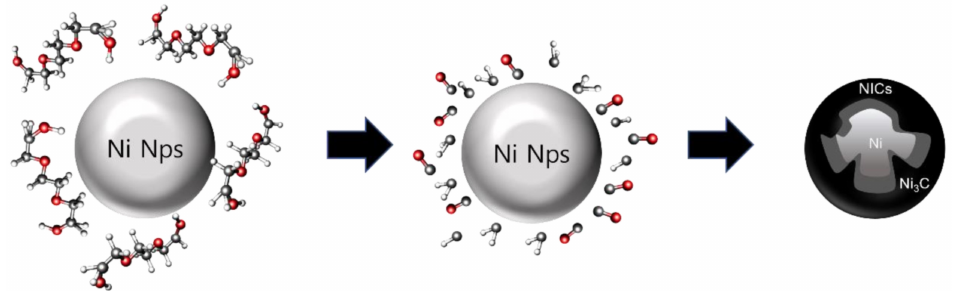
Figure 7. Suggested growth mechanism of